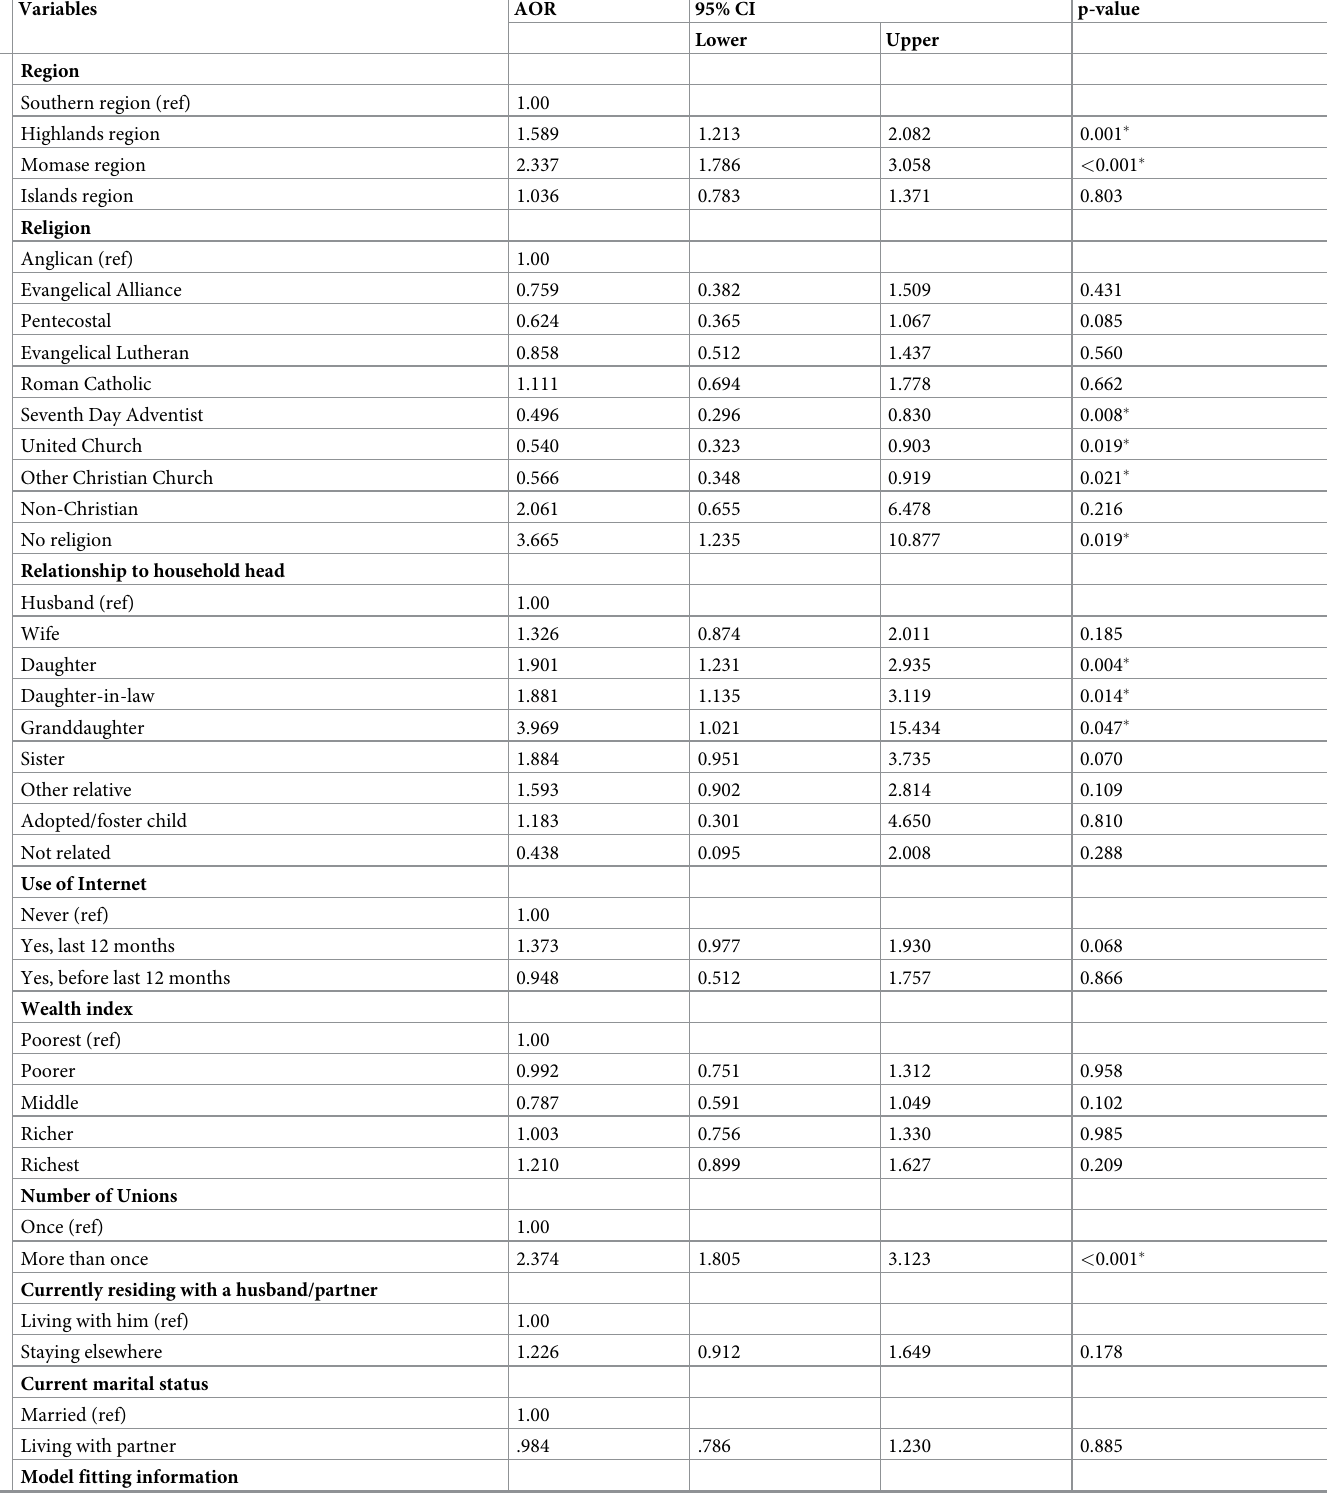
Table 3. Multiple logistic regression analysis on factors associated with cigarette